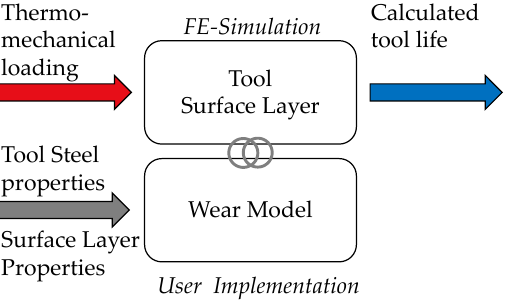
Figure 1. Scope of this paper: Novel approach for the wear model implementation on the tool surface layer.